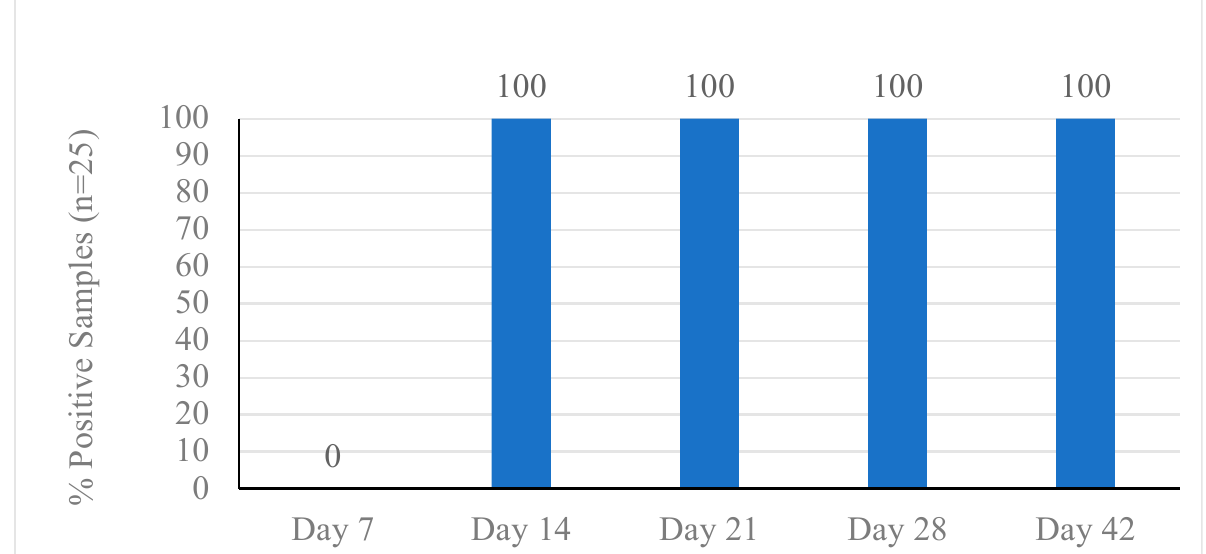
Figure 1. Campylobacter jejuni prevalence in boot cover swabs during grow-out of flock 1.